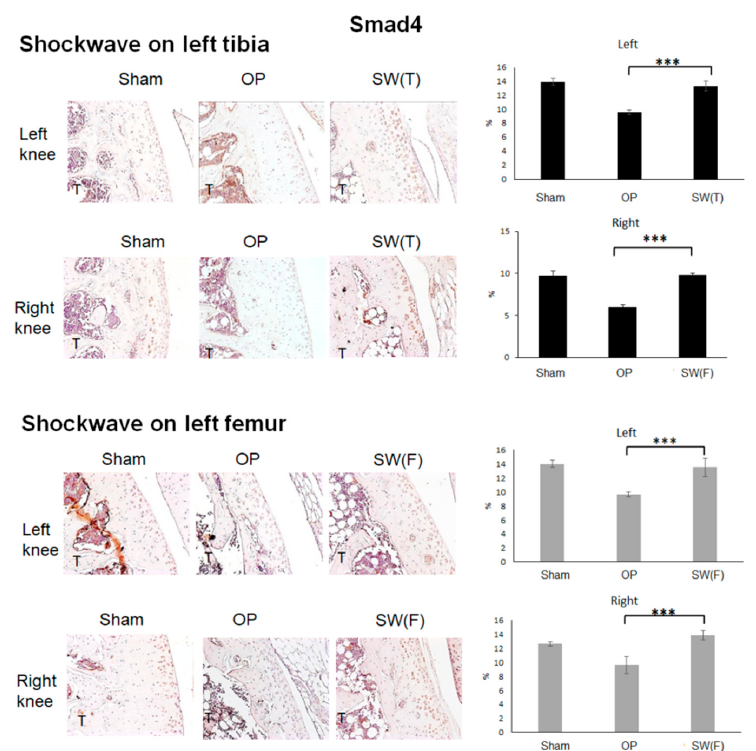
Figure 4. Shockwave therapy induced long-range effects on the expressions of BMP2, BMP4, and SMAD family member 4 (Smad4) in the articular cartilage (×100 magnification) of the tibia of the right and left knees in the Sham, OP, SW(T), and SW(F) groups. T = tibia. *** p < 0.001. Values are the mean ± SEM. Further, the BMP and Wnt signaling pathways play critical roles in cartilage homeostasis, proliferation, and differentiation. Wnt3a and Cyclin D1, which are the key factors in the Wnt signaling pathway, were surveyed in the articular cartilage after SW by immunohistochemical analysis and were found significantly ( p < 0.001) decreased in the OP group and increased in the SW(T) and SW(F) groups (Figure 5). These results demonstrated that SW on the left tibia or femur induced long-range protective effects to modulate the key factors of BMP and Wnt signaling to articular cartilage repair in the osteoporotic knee.